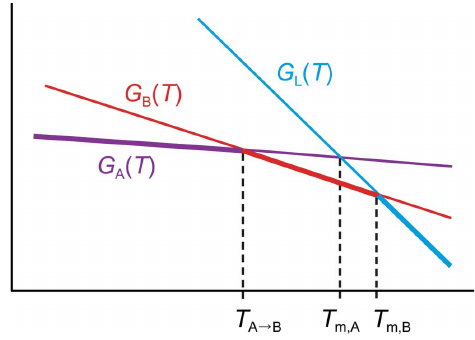
Figure 22 Virtual melting point T m,A of phase A: the Gibbs free energies of phase A, phase B and the liquid as a function of temperature are shown. Phase A is the most stable phase at low temperature, and when the temperature increases phase A converts to phase B before melting. T m,A and H m,A cannot be measured directly (at ambient pressure), but T m,A must lie between T A ! B and T m,B . The temperature dependence of the Gibbs free energies is represented as straight lines for clarity, in reality these lines are curved. A similar situation occurs when a phase decomposes before melting. The most stable phase at each temperature is shown in